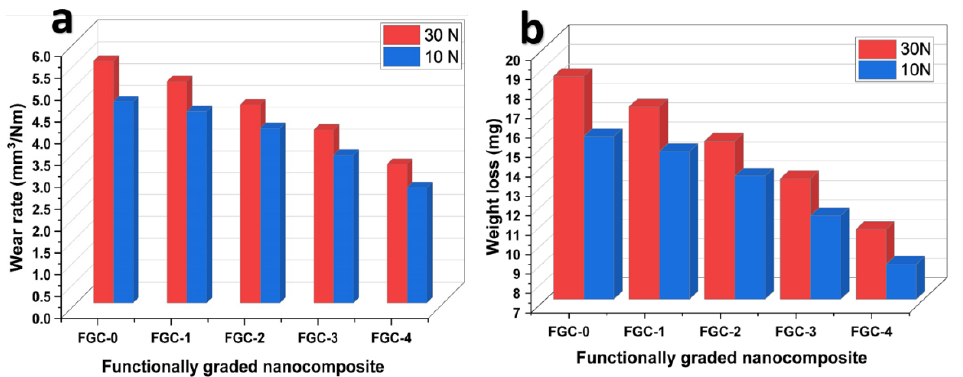
Figure 14. Effect of different hybrid reinforcements on the ( a ) wear rate of FGCs at 10 and 30 N and ( b ) weight loss.